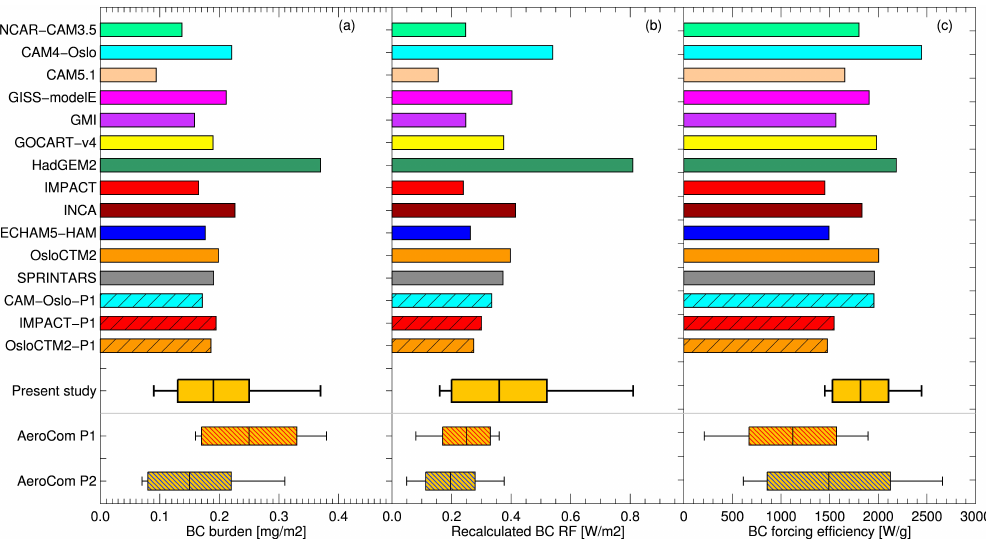
Fig. 1. Modeled BC global mean (a) burden, (b) RF and (c) forcing efficiency. Yellow boxes indicate mean, one standard deviation and max/min values. Mean values and spreads for AeroCom P1 and P2 (hatched whisker boxes) are taken from Schulz et al. (2006) and Myhre et al. (2013)